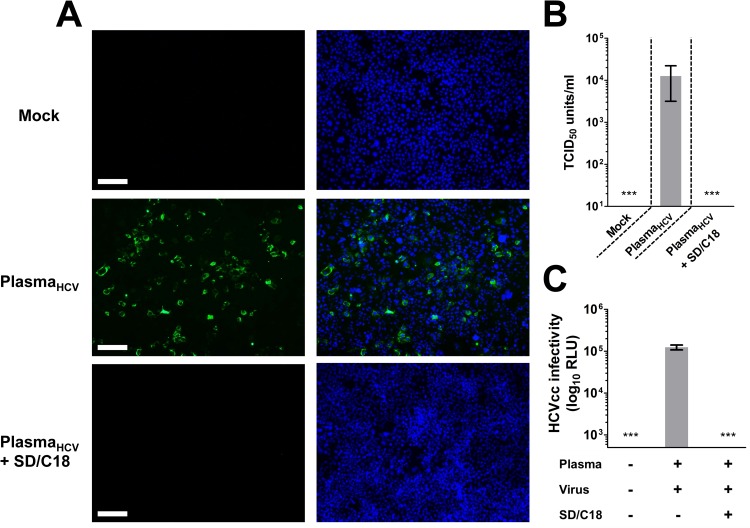
SD treatment efficiently removes HCV infectivity from virus-containing plasma.Infectivity of HCV-spiked plasma (PlasmaHCV) with or without SD treatment followed by C18 filtration (SD/C18) was analyzed by: A. Immunofluorescence staining of viral NS5A (magnification: 100×; scale bar = 100 μm); B. Virus titer determination by TCID50 analysis (units/ml); and C. Luciferase reporter measurement of viral infectivity (RLU). All quantifiable data and representative micrographs are from three independent experiments; error bars indicate means ± SEM (***: P < 0.001). See text for details.